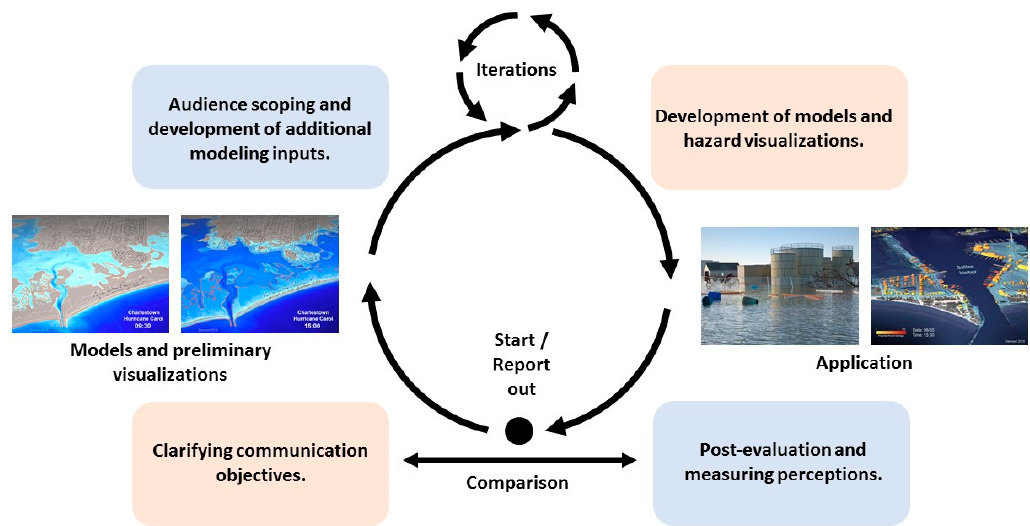
Figure 8. a diagram of the reflexive process advocated by the authors that facilitates comparison of objectives to results and the ability of audiences to shape visualization outputs. Image: Authors.